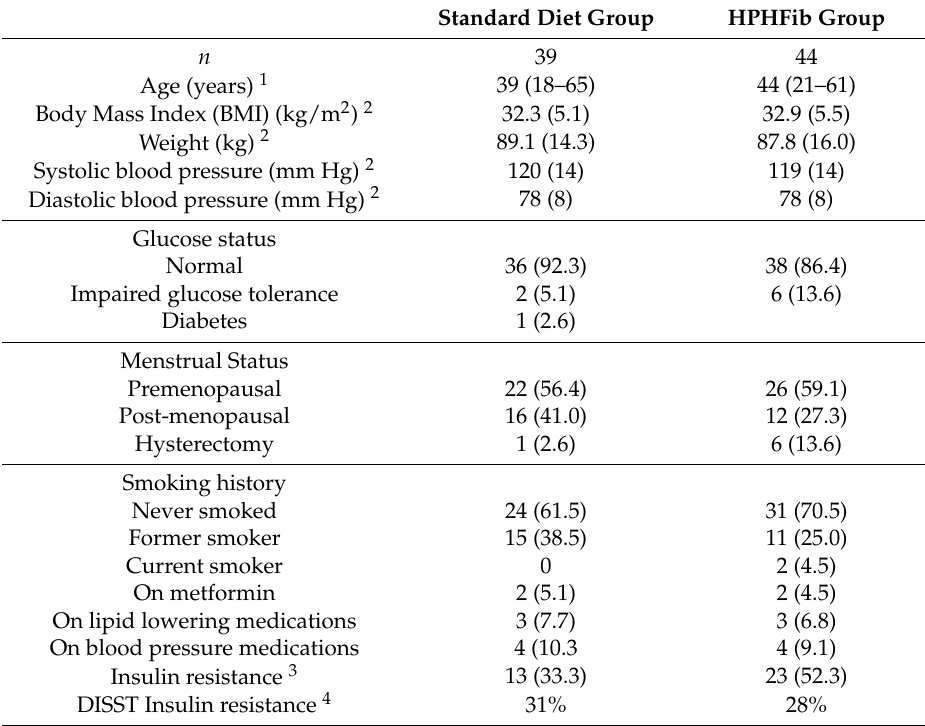
Table 1. Baseline demographic and clinical details for all participants randomized to